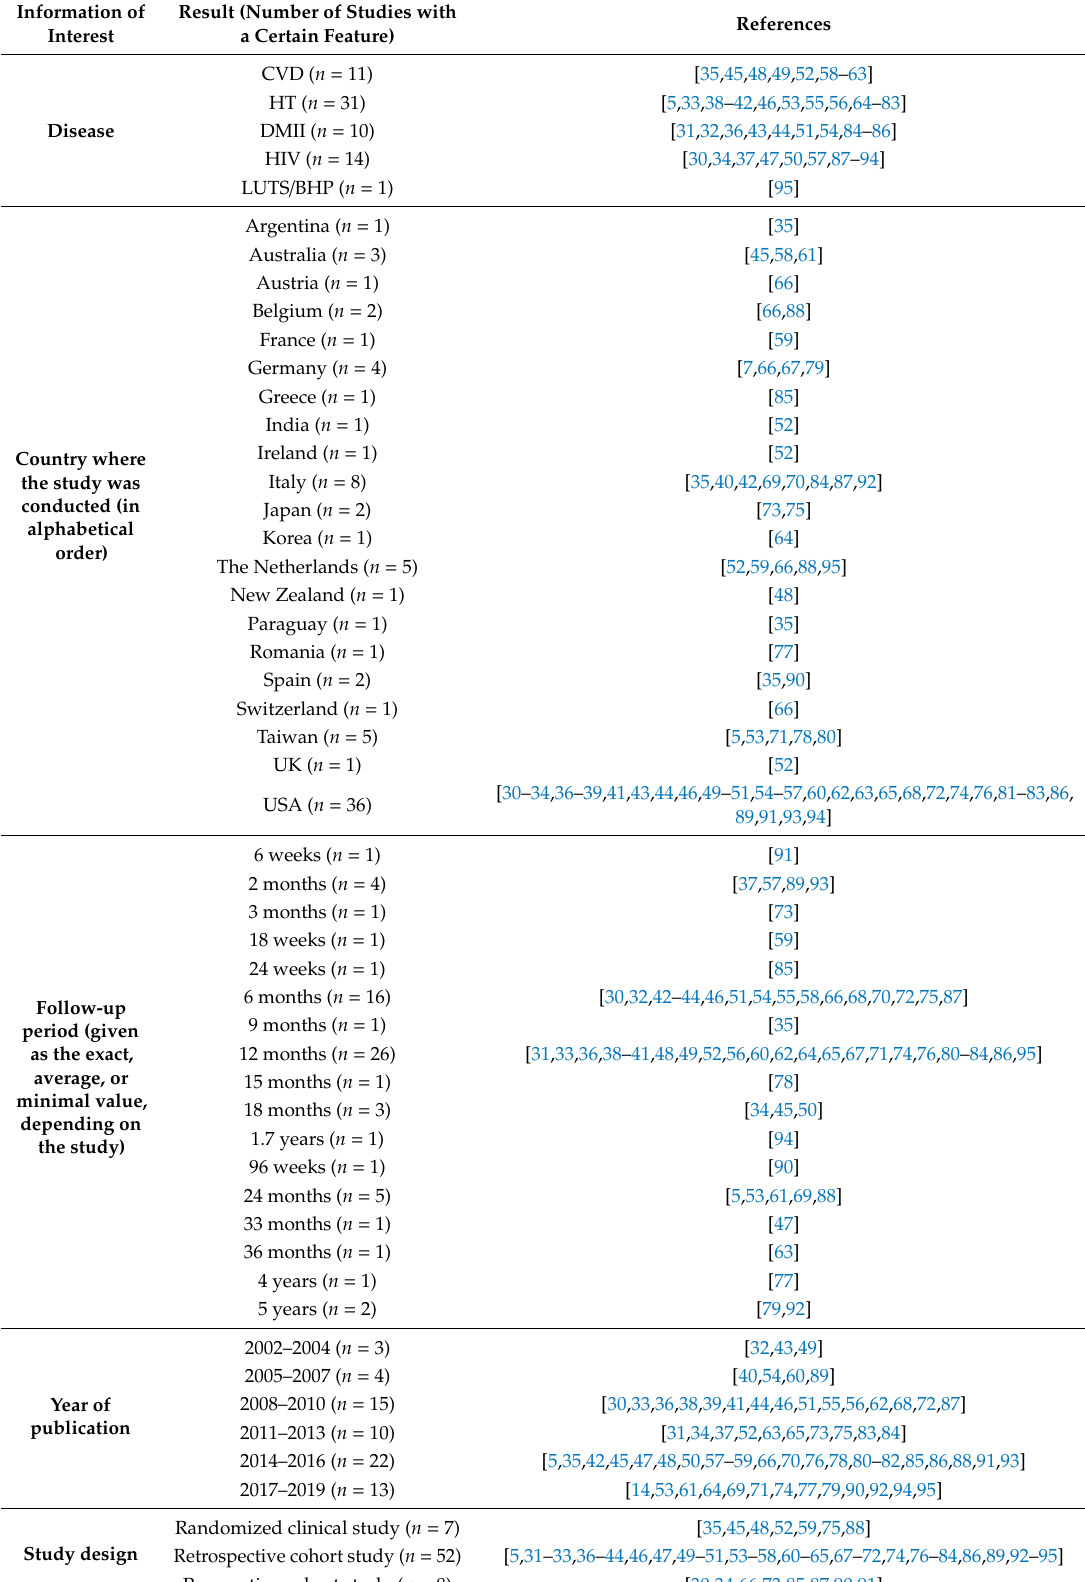
Table 2. General information about reviewed articles ( n =